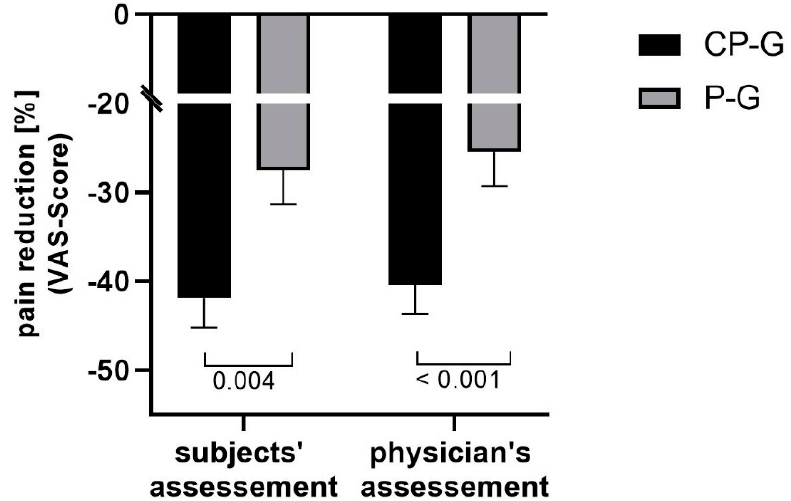
Figure 3. Relative changes in activity-related pain (VAS Score). Data are shown as mean ± SEM. The significance of the relative changes in pain during the activities assessed by the subjects and the physician was con fi rmed by the medium e ff ect sizes (d = − 0.432) and (d = −